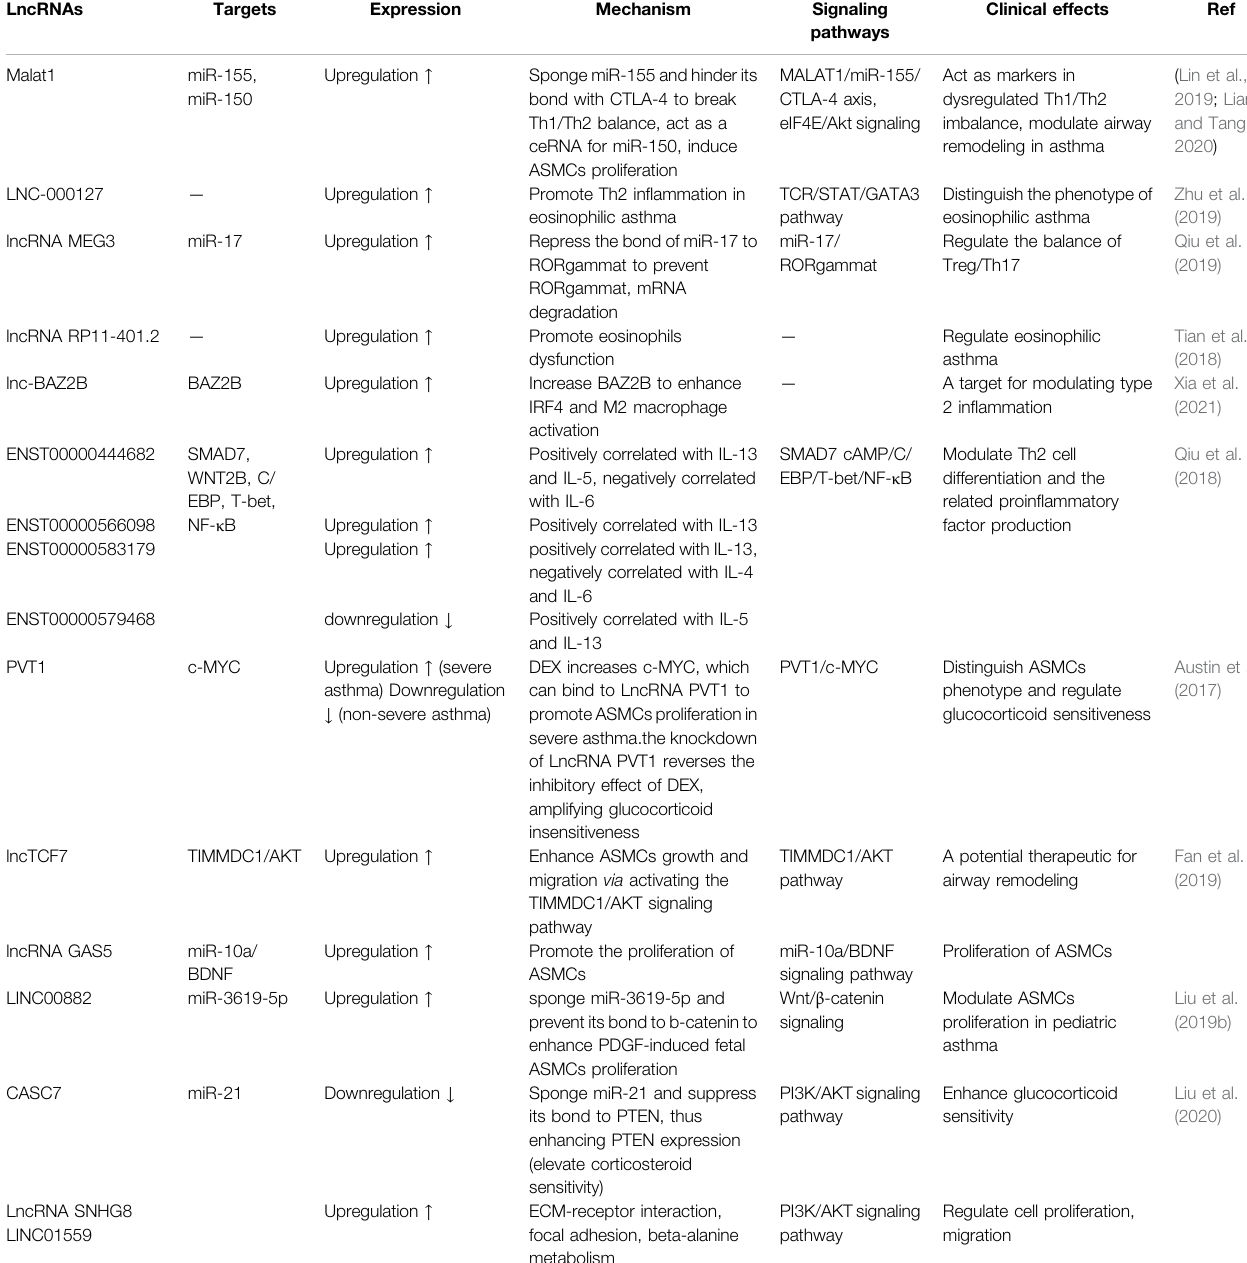
TABLE 2 | Dysregulated lncRNAs in